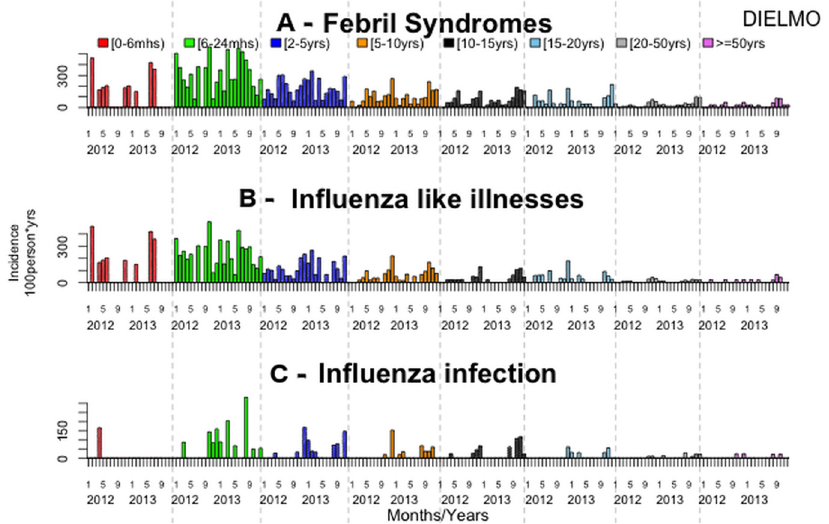
Fig 2. Monthly incidence density rates by age group in Dielmo, 2012 –